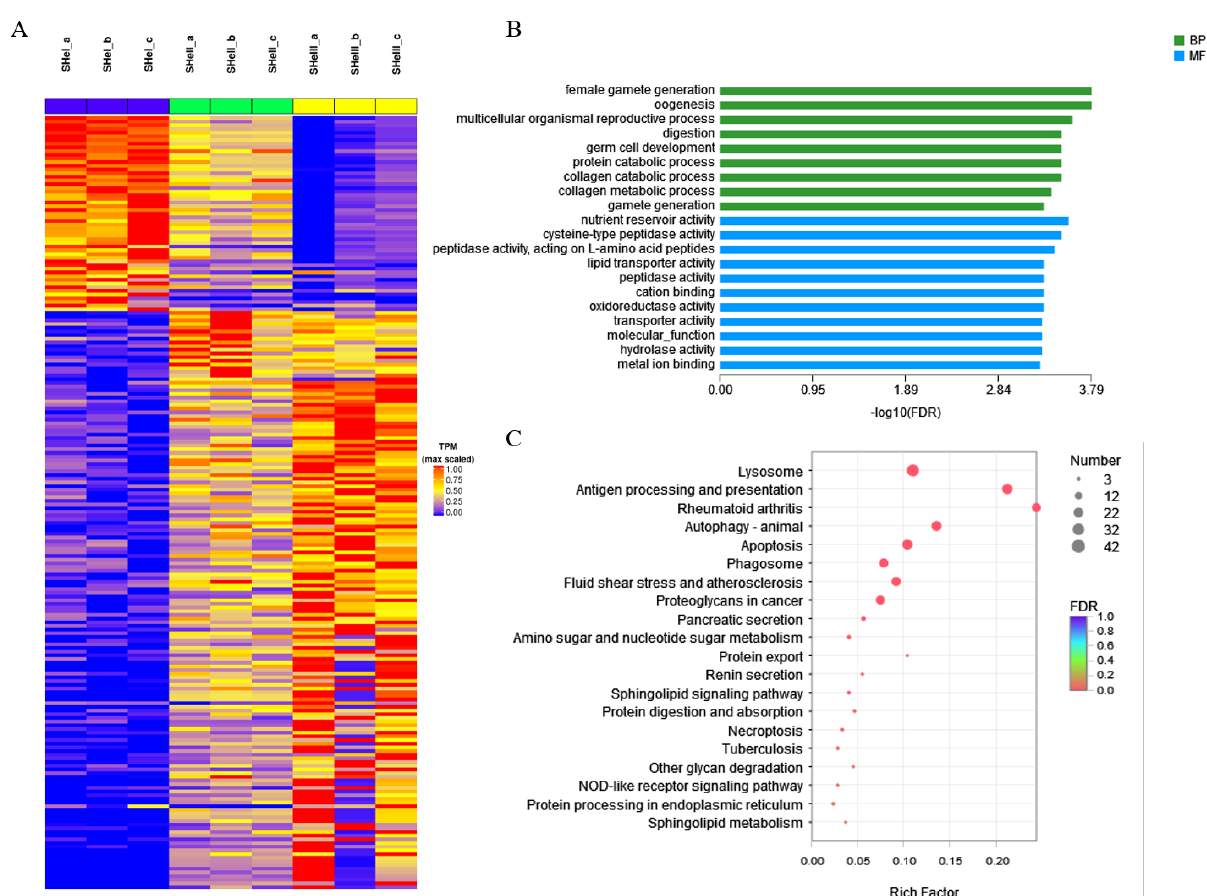
Figure 8. STEM analysis of DEGs in the hepatopancreas. ( A ) Heatmap of DEGs from different groups of the hepatopancreas. ( B ) GO and ( C ) KEGG pathway enrichment analysis of DEGs by time